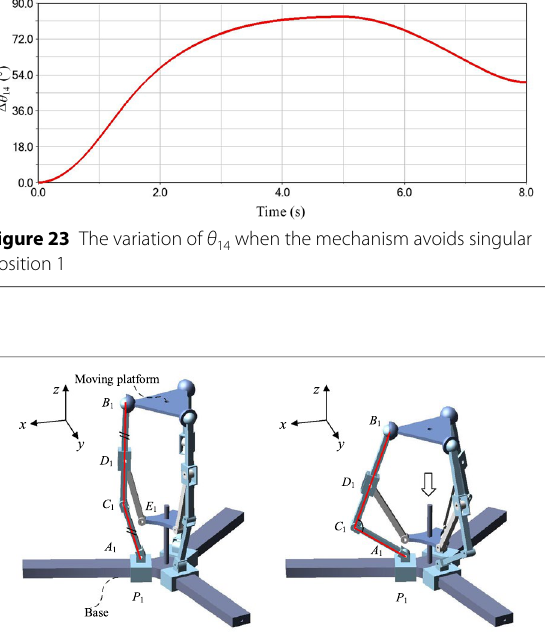
Figure 24 Decreasing the height of the lifting platform to avoid singularity at the singular position 2